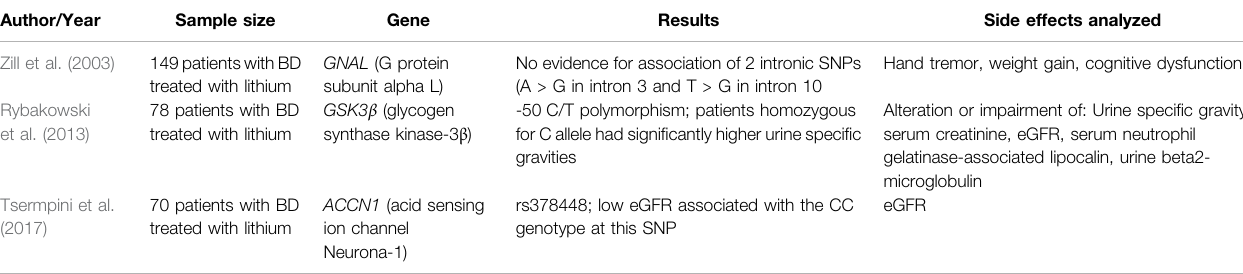
TABLE 4 | Genetic studies on side effects of lithium in patients with bipolar